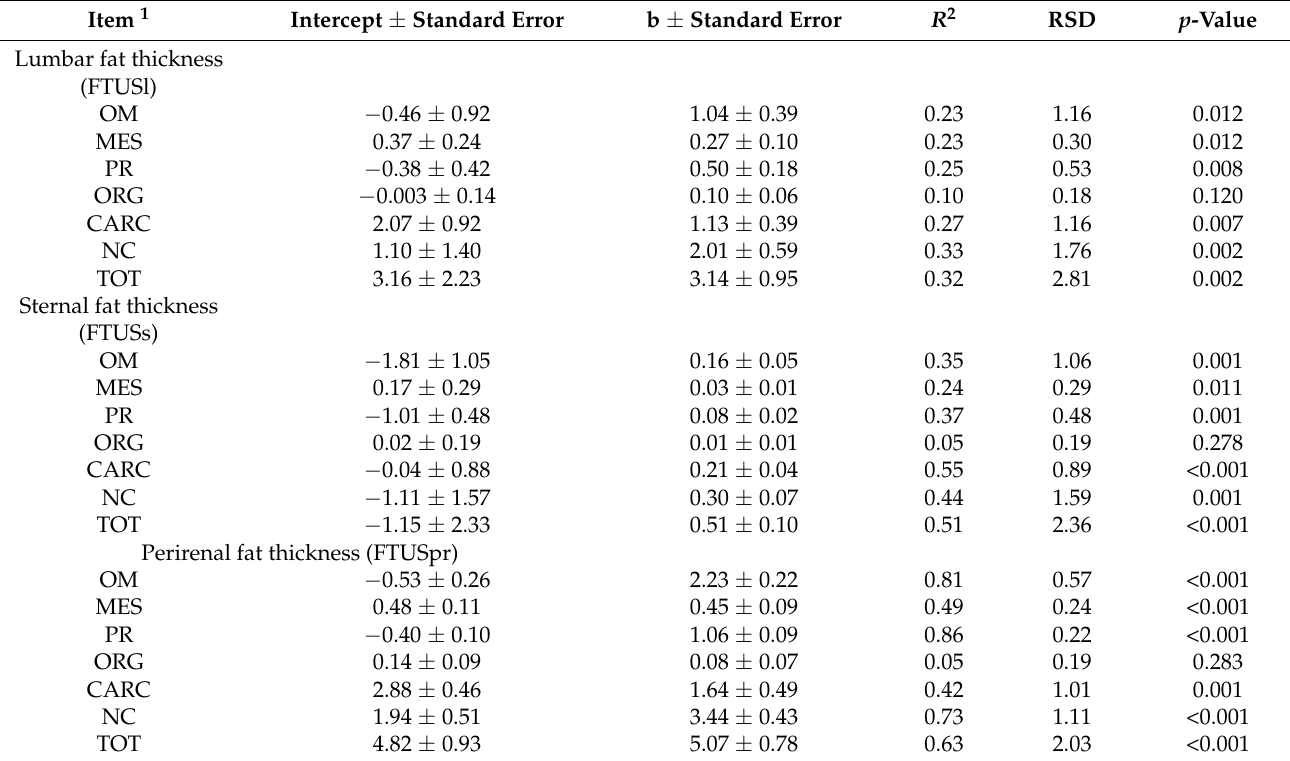
Table 3. Regression equations (y = a + bx), coefficient of determination ( R 2 ), and residual standard deviation (RSD) values for estimate of the different fat depot weights (kg) and the total weight of all fat combined (y variables) based on the pre-slaughter measurement values lumbar, sternal, and perirenal fat thickness depths measured by ultrasound (FTUSl, FTUSs, and FTUSpr, respectively) (x variables).